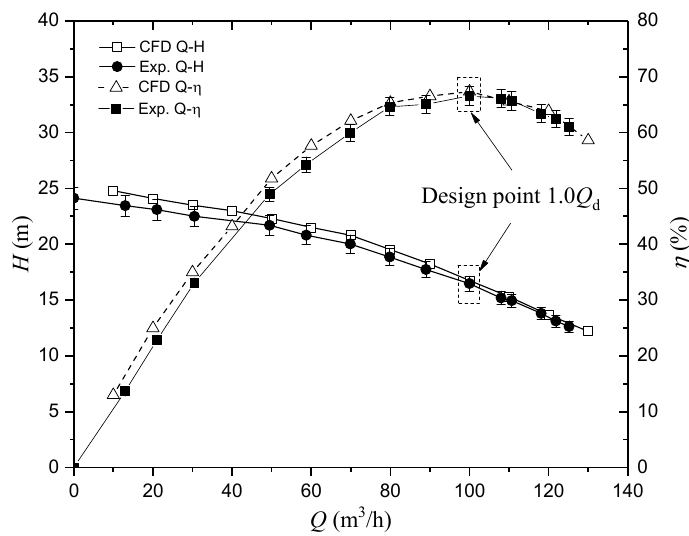
Figure 7. Numerical calculation results validation.